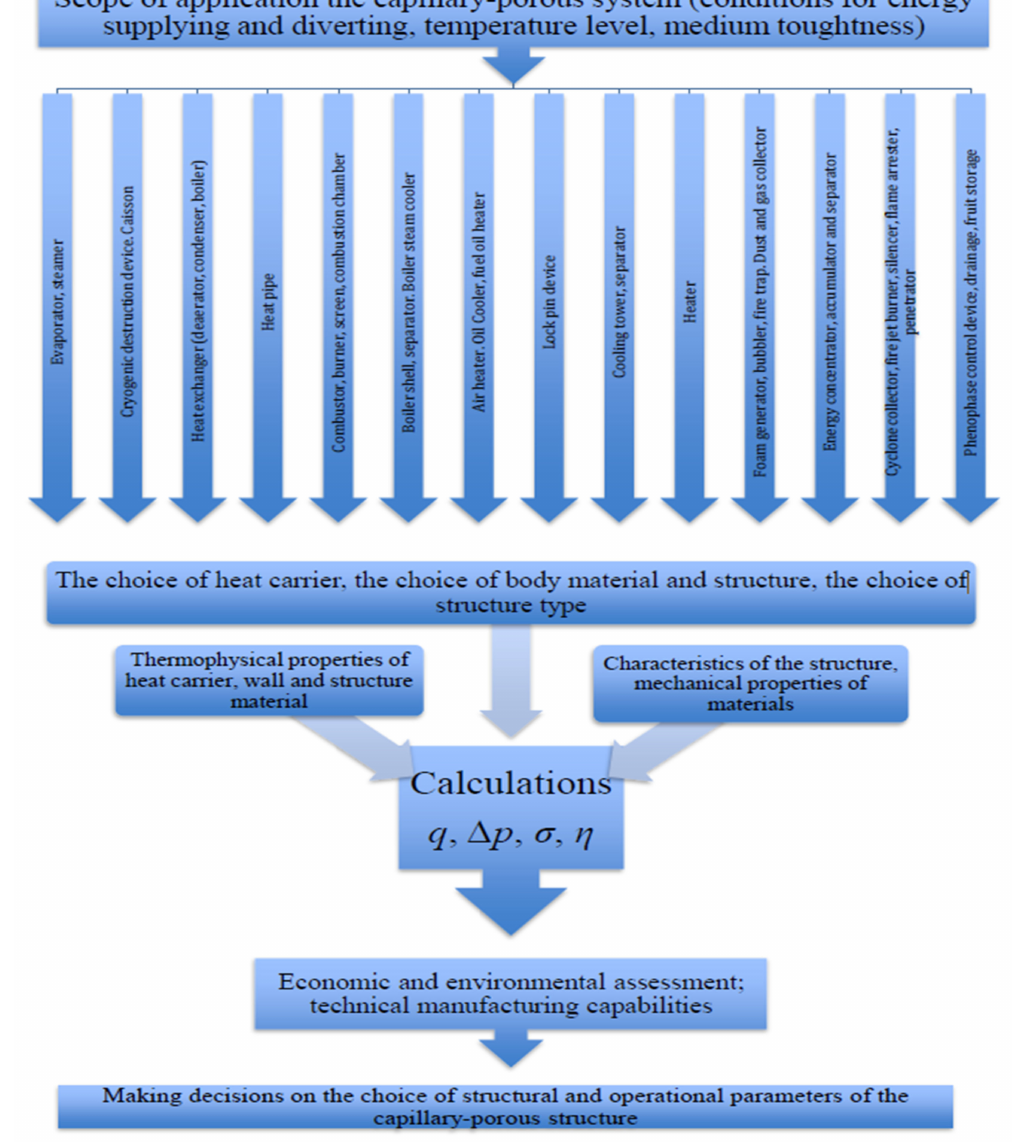
Figure 1. Block diagram of capillary-porous system